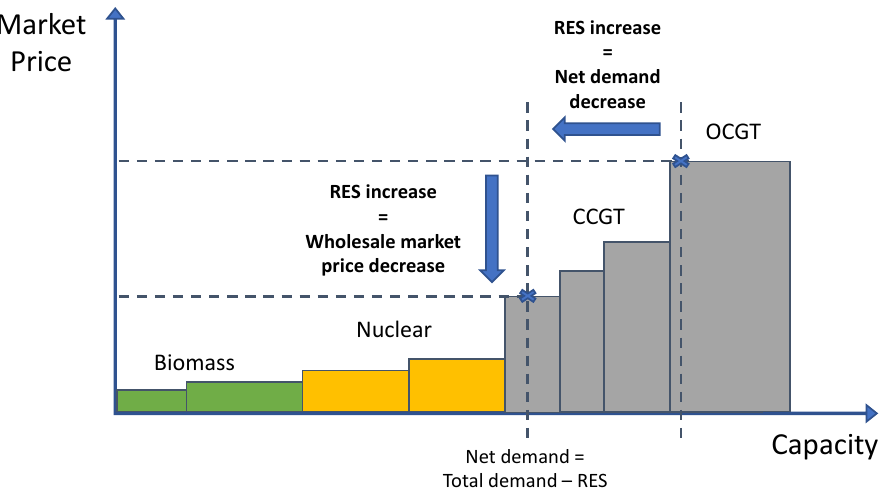
Figure 15. Illustrative effects of the COVID-situation on the wholesale market price. The wholesale market price reduces due to COVID. The higher RES share after the lockdown lowers the net demand which leads to a wholesale market price